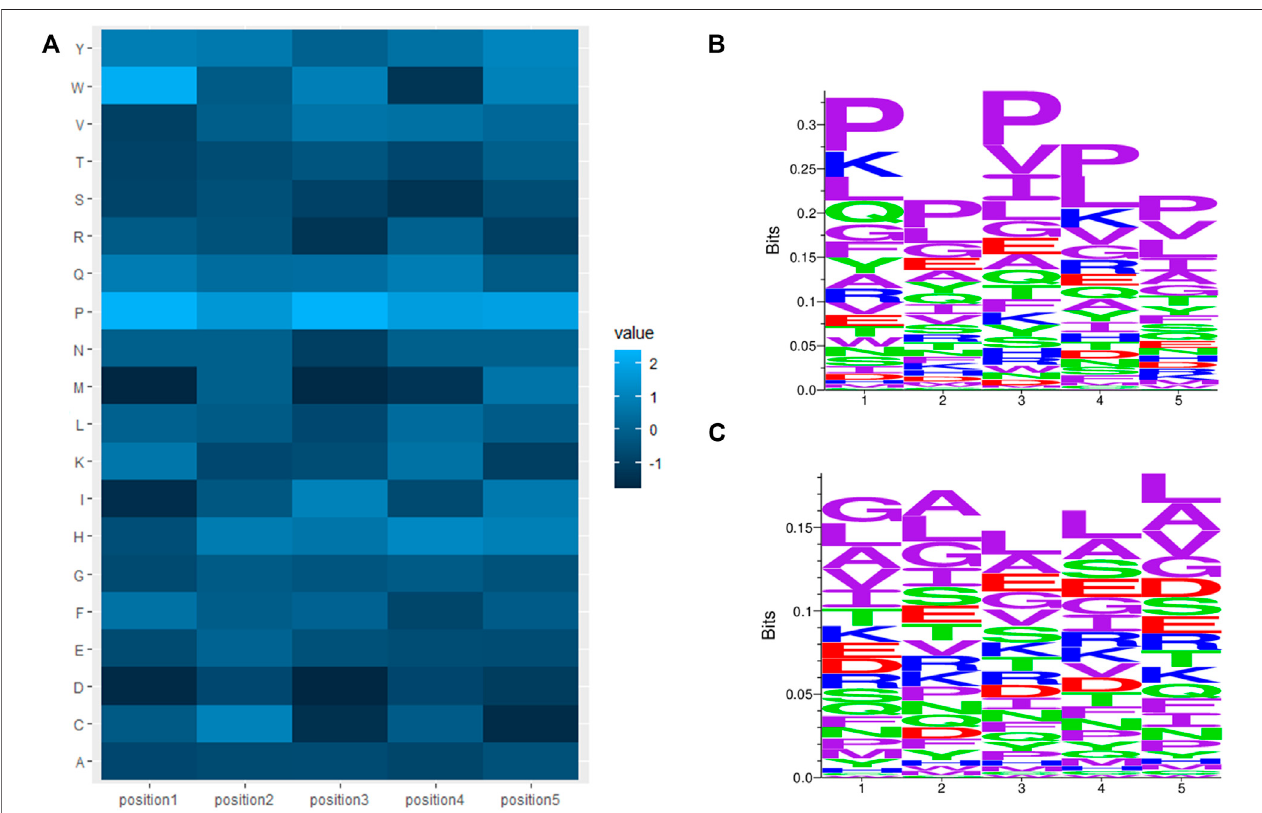
FIGURE4| C-terminalanalysisofAHTPpositivedataandnon-AHTPnegativedata: (A) Heatmapoflogoddsratios,wherealightercolordenotesoverrepresented aminoacidresiduesinAHTPscomparedtonon-AHTPs(positivelogoddsscore)andadarkercolordenotesunderrepresentedaminoacidresiduesinAHTPscompared tonon-AHTPs(negativelogoddsscore). (B) Sequencelogosofpositionsoneto fi veoftheAHTPpositivedataset. (C) SequencelogosofC-terminalpositionsoneto fi ve of the non-AHTP negative